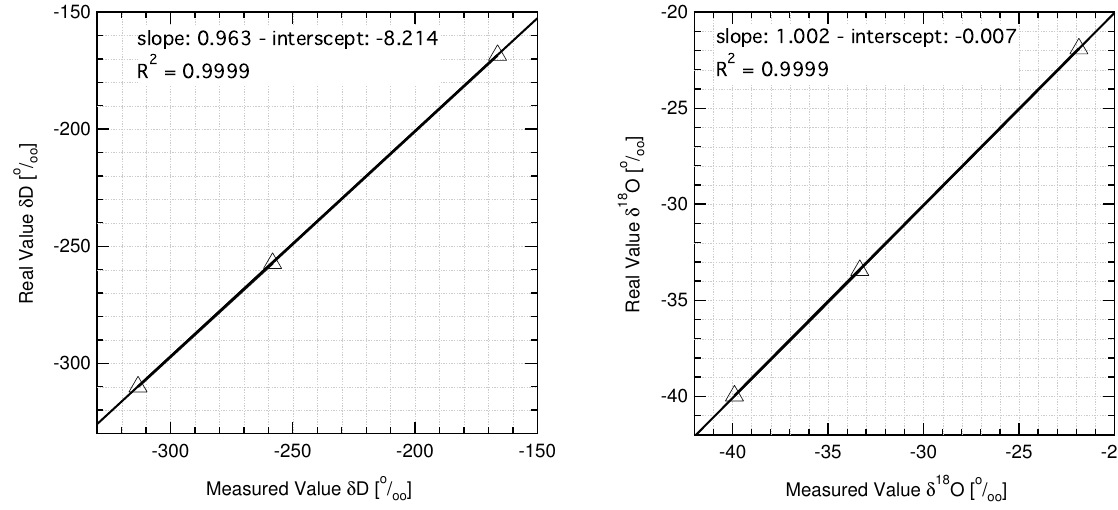
Fig. 3. VSMOW calibrations with three water standards “ − 22”, “ − 40” and “NEEM”; Left – δ D, right – δ 18 O.